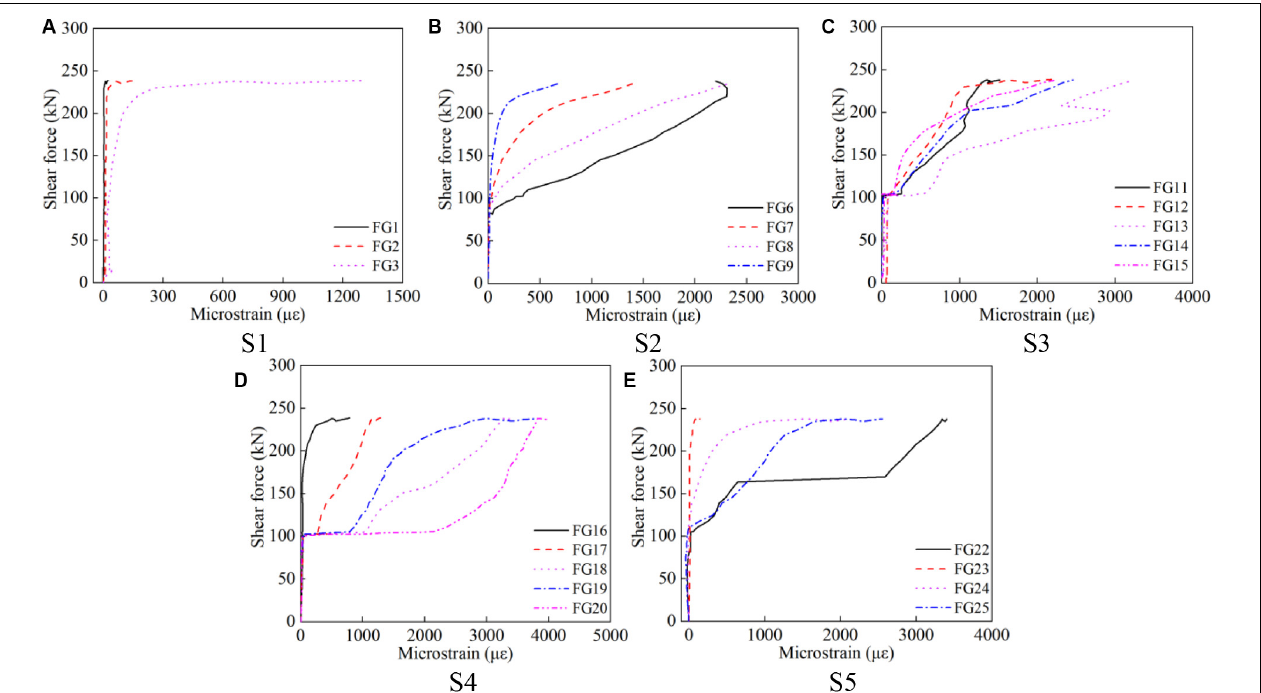
FIGURE 10 | Strain development in CFRP strips for EB-4-0. (A) S1, (B) S2, (C) S3, (D) S4, and (E) S5.